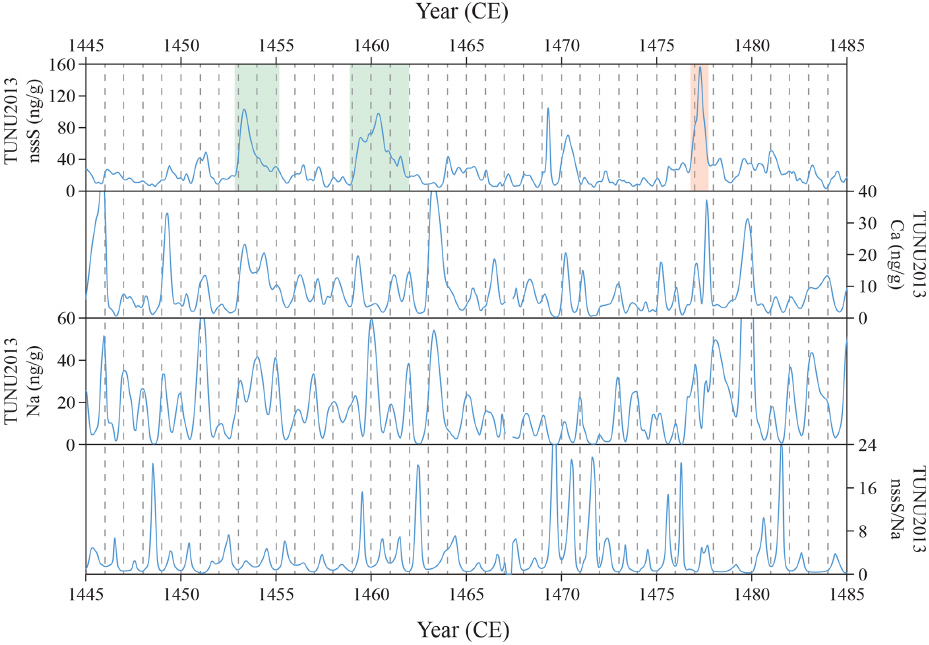
Figure 5. High-resolution nssS and annual layer dating of the TUNU2013 ice core between 1445 and 1485CE using a multiparameter approach. Concentration records are shown for nssS, Ca, Na and nssS / Na, with grey dashed lines indicating the assigned years. The red shaded bar indicates the location of the V1477 tephra layer in the TUNU2013 record. The green shaded bars indicate the two sulfate peaks in the 1450sCE in